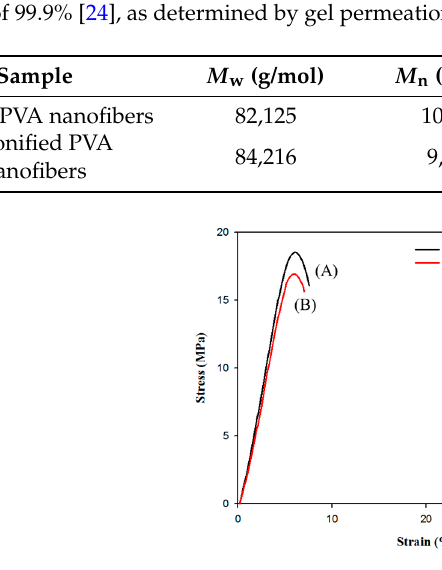
Figure 11. Stress-strain curve of: ( A ) general electrospun PVA nanofibers; and ( B ) fully saponified PVA nanofibers formed by heterogeneous saponification of electrospun PVAc nanofibers. The concentration of these nanofibers was at 15 wt % and the saponification solution was prepared using NaOH (10 g), Na 2 SO 4 (10 g), MeOH (10 g) and H 2 O (100 g). The saponification temperature and time were 25 °C and 30 h, respectively. The DS value of the fully saponified nanofibers was 99.93%.